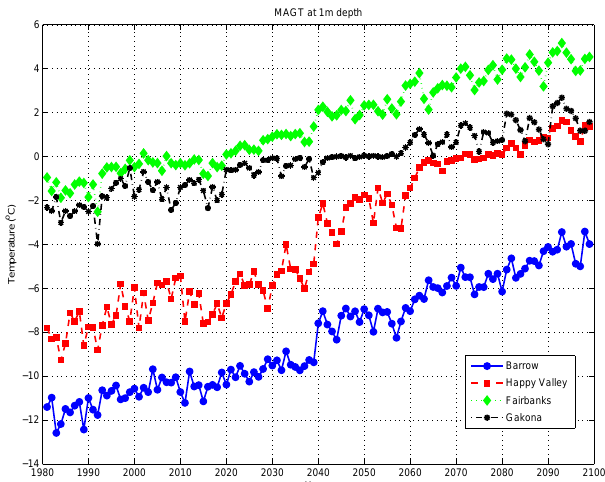
Fig. 13. Projected MAGT at 1m depth for four different lo- cations (Barrow 71.32 ◦ N, − 156.65 ◦ W, Happy Valley 70.38 ◦ N, − 148.85 ◦ W, Fairbanks 64.95 ◦ N, − 147.62 ◦ W, Gakona 62.41 ◦ N, − 145.15 ◦ W). Forcing from the downscaled five composite GCMs with A1B emission